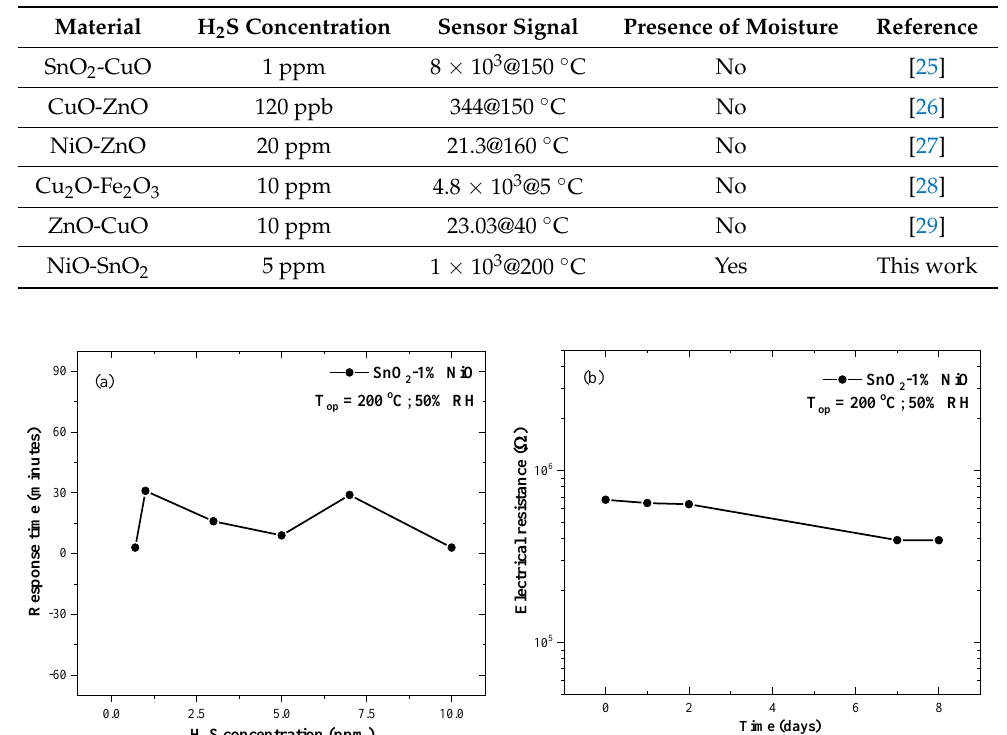
Table 2. Literature review of various sensing materials towards H 2 S detection.